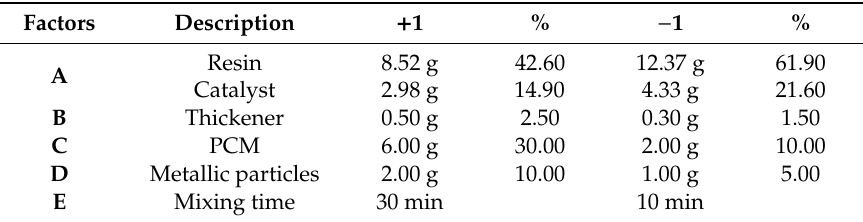
Table 2. Values for the Plackett–Burman